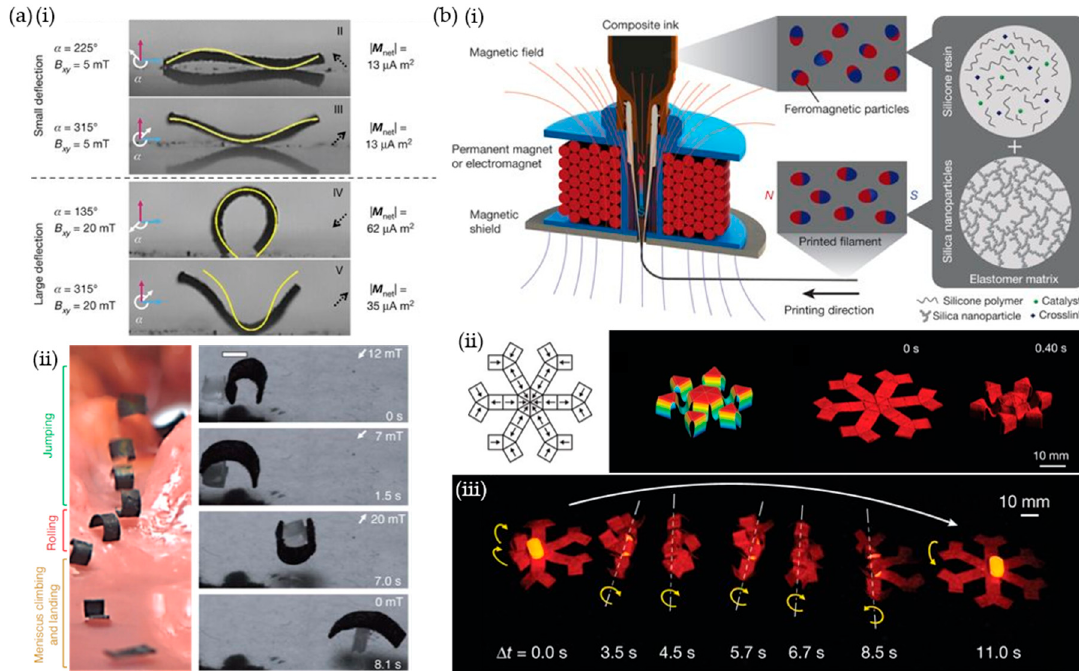
Figure 5. Multimodal magneto-actuation through multiple magneto-alignments in single soft robots. ( a ) ( i ) Reconfigurable soft body embedded with a counterclockwise alignment of polarity. ( ii ) Navigation across a synthetic stomach phantom and cargo transportation through multimodal locomotion (scale bars: 1 mm). ( b ) ( i ) 3D printing process using composite inks composed of uniaxial reoriented magnetic particles under a magnetic field. ( ii ) Printing design of magnetic polarity with a top-down view and actuation of the printed hexapedal and auxetic structure. The height of the auxetic 3D structure is 5 mm at the bottom of the panel. ( iii ) Carrying a pharmaceutical pill with a six-legged structure. ( a ) was used with permission [9]. Copyright 2018, Nature Publishing Group. ( b ) Reproduced with permission [10]. Copyright 2018, Nature Publishing Group.